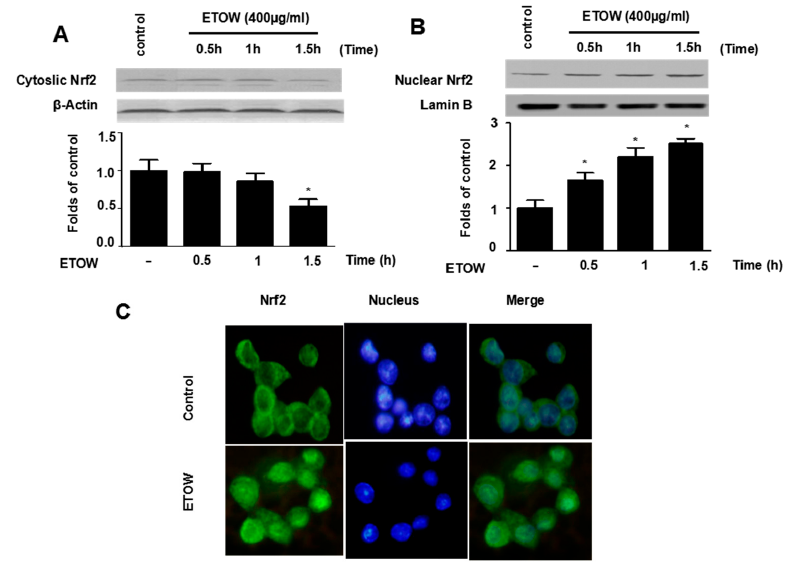
Figure 4. Effects of ETOW on Nrf2 translocation in HT22 cells. HT22 cells were incubated with 400 µ g/mL of ETOW for 0.5, 1, or 1.5 h. The cytosolic and nuclear extracts were fractionated using PER-Mammalian Protein Extraction buffer. Nrf2 protein expression was detected by Western blot in cytosolic and nuclear extracts ( A , B ). Nrf2 translocation was detected by immunofluorescence ( C ). The levels of cytosolic and nuclear Nrf2 were normalized to the β -actin and lamin B, respectively. * p <